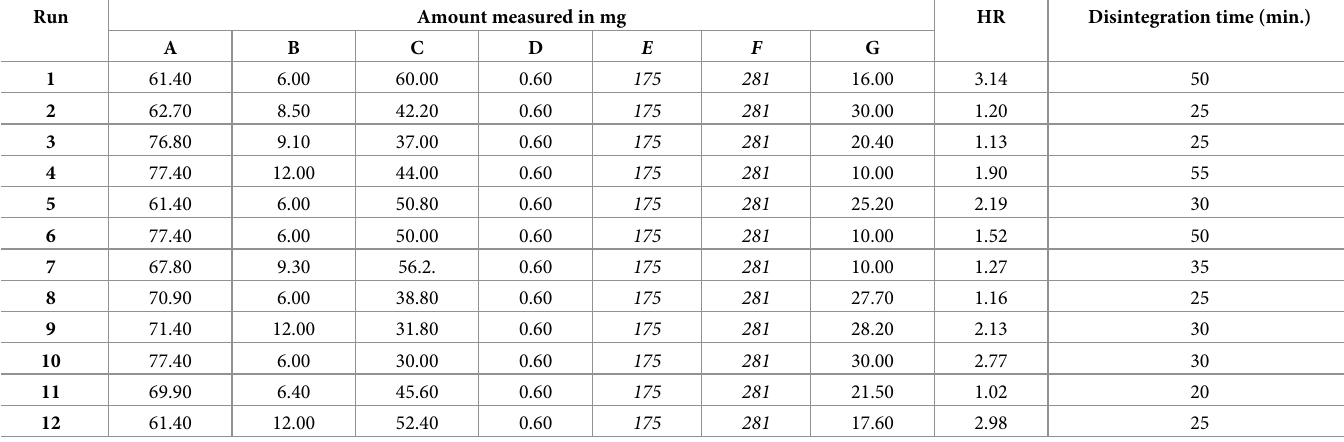
excipients: magnesium carbonate (A), magnesium stearate (B), talc (C), sodium benzoate (D), sodium bicarbonate (G), and active ingredient (mixture of MCFE and AEFE) on granules flowability and capsule disintegration time responses (Table 6). The granules flowability analysis (response variable) showed a statistically significant qua- dratic model fitting (Table 7). The ANOVA results indicated the model F-value of 59.87 implies the model is significant ( p = 0.0165). There is only a 1.65% chance that an F-value this large could occur due to noise. The linear terms and all second-order interaction terms were Table 6. The compositions and quality attributes of herbal capsule formulation. Run Amount measured in mg HR Disintegration time